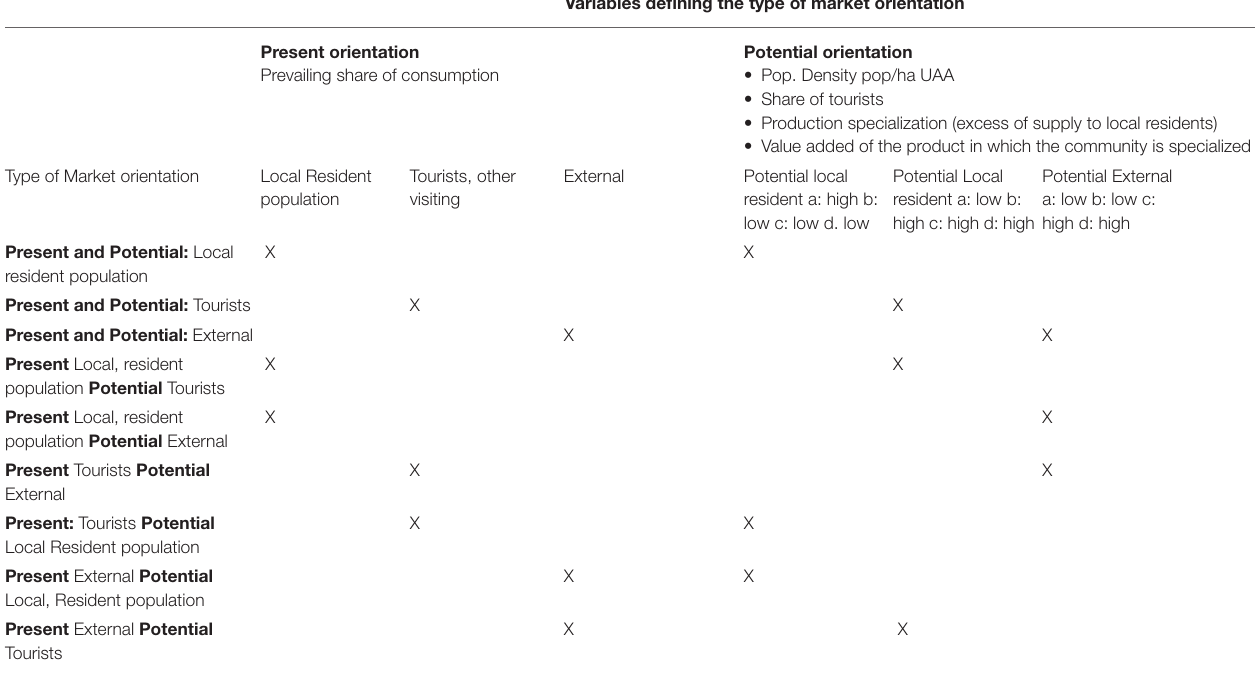
TABLE 3 | Present and Potential market orientation